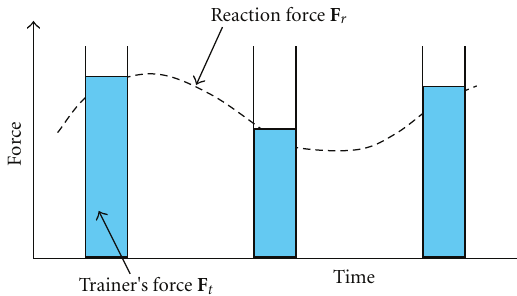
Figure 14: Presentation of two kinds of forces, F r and F t